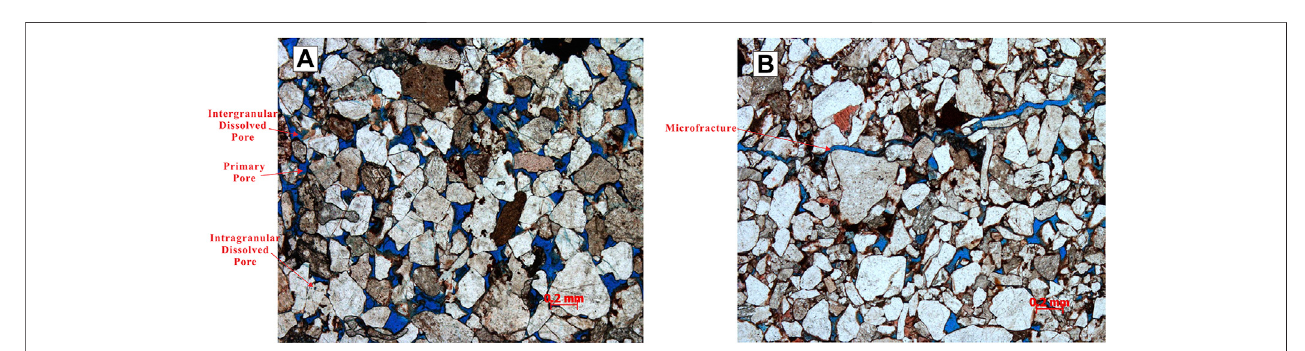
FIGURE 7 | Petrological characteristics of Bozi 3 gas reservoir observed under the microscope. (A) Well BZ301, 5,932.85 m, Third Bashijiqike Formation; (B) BZ301, 5,838.82 m, Third Bashijiqike Formation.